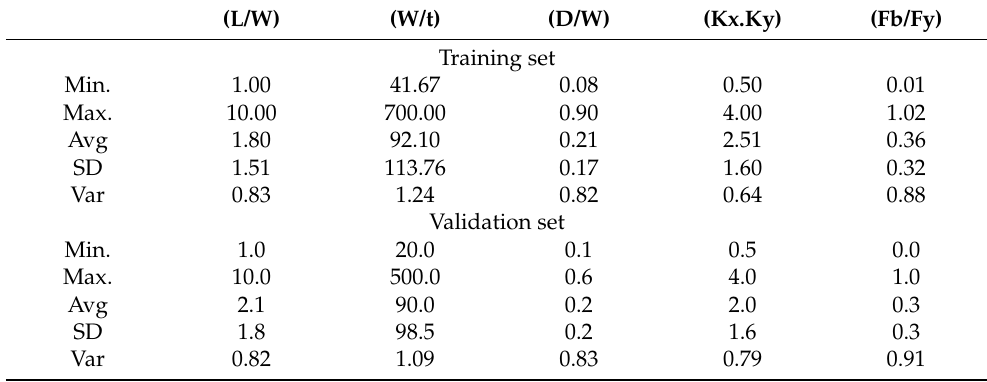
Table 1. Statistical analysis of collected database.